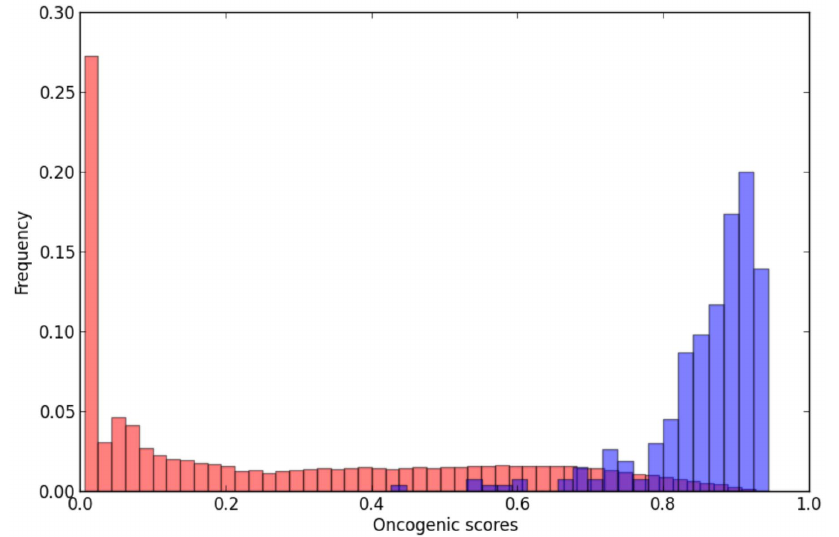
Figure 4. Frequency distribution of known oncogenic interactions per intervals of oncogenic scores. The blue and red bars show, respectively, the frequency distributions of known oncogenic interactions and all interactions in the wINHGI per 0.2 intervals of oncogenic scores.